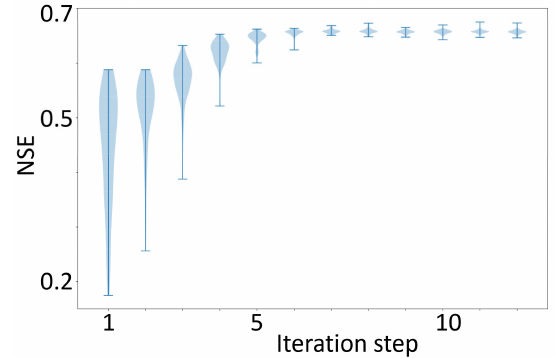
Figure 7. Violin plot of NSE of each swarm at different iteration step, i